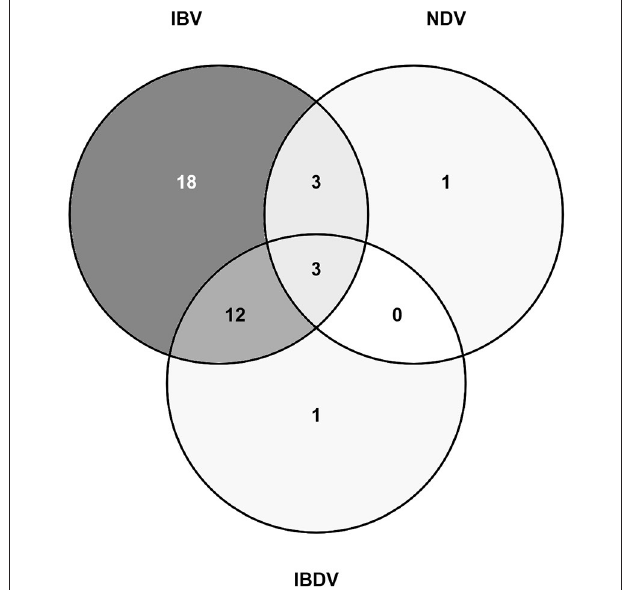
FIGURE 3 | Venn diagram showing the number of study flocks where a sample tested positive for NDV, IBDV, and/or IBV RNA by rRT-PCR.